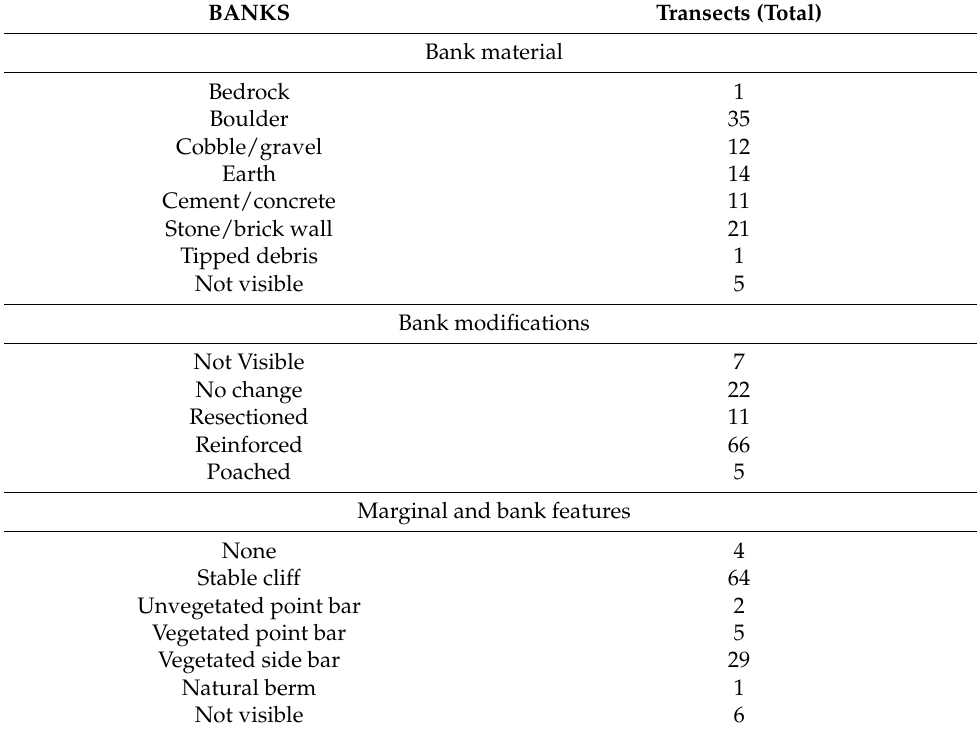
Figure 5. Aspects associated with Section D: ( a ) Minor bridges; ( b ) Major bridges. - Section E: Physical attributes (1-m wide transect) (Tables 2 and 3). Table 2. Representativeness of observations in Section E for the